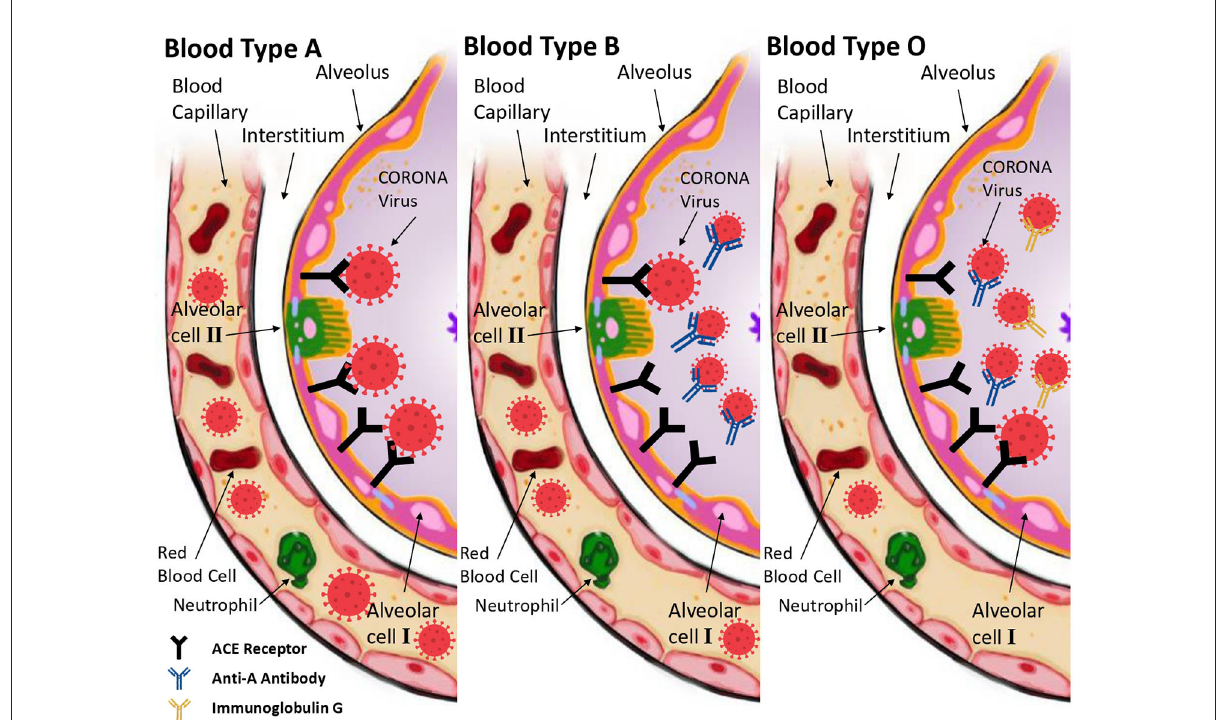
FIGURE1 The molecular mechanism that explains how and why the ABO blood group affects a human’s vulnerability to COVID-19 disease. The A blood group’s lack of antibodies makes it easier for SARS-CoV-2 to enter the host cell and cause the subsequent viral infection (Left side) . Anti-A antibodies prevent the S protein of the virus from interacting with ACE-Receptors on the cell surface in blood group B cells (Middle) . Finally, blood group O provides further protection against COVID-19 infection due to the presence of anti-A antibodies and IgG antibodies (Right side)